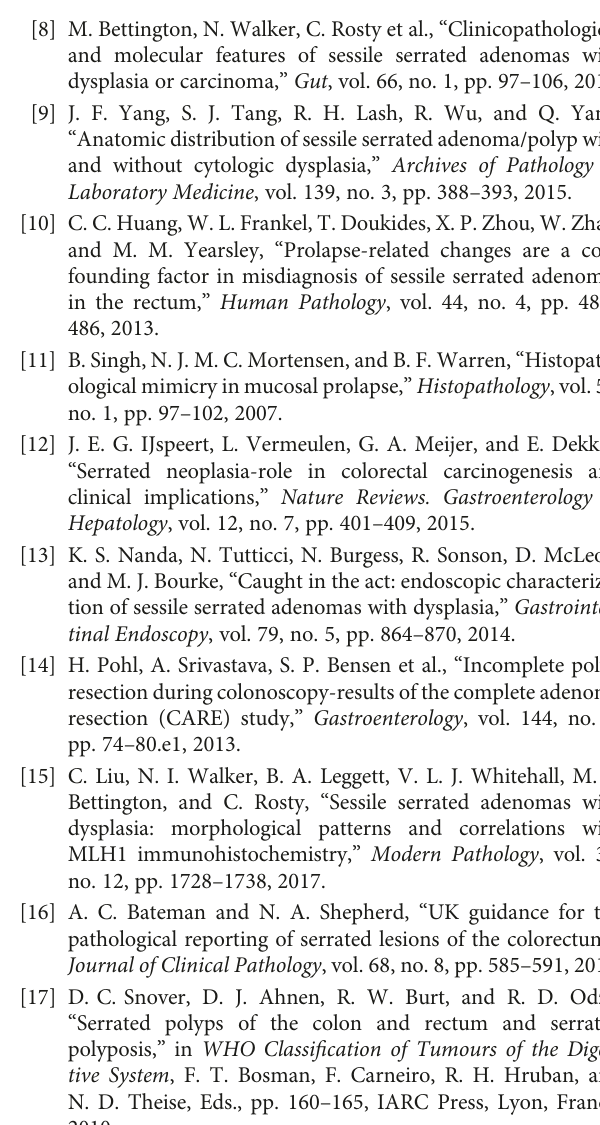
HYP with prolapse e ff